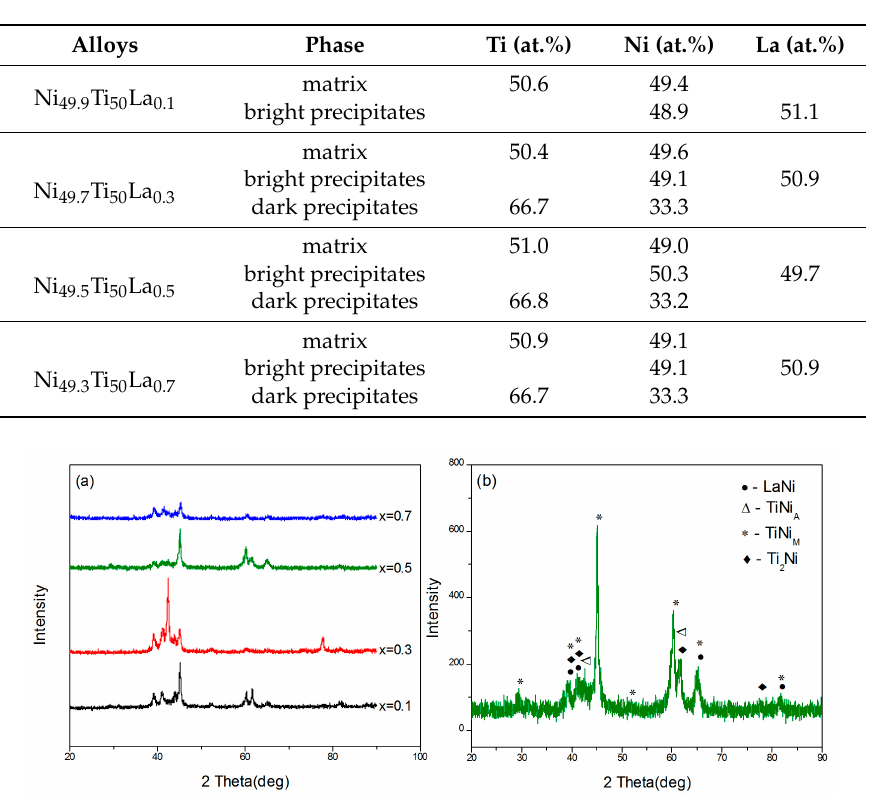
Table 1. Chemical composition of phases in Ni 50 − x Ti 50 La x alloys.